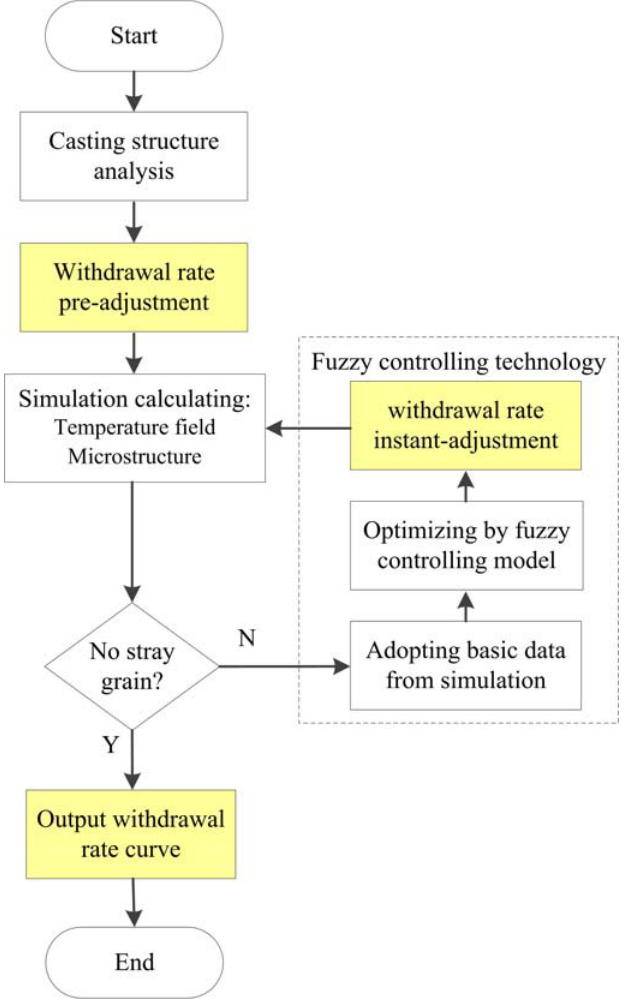
Figure 3. The flow chart of withdrawal rate optimizing by